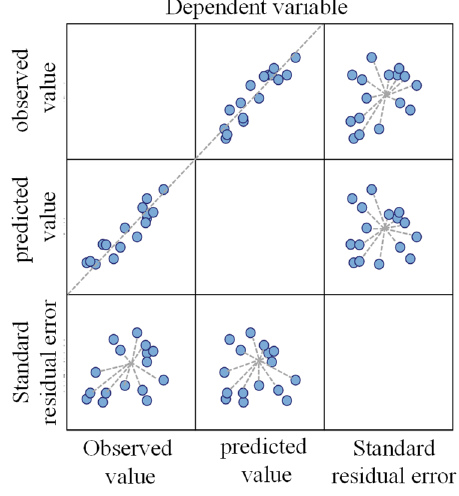
Figure 2. Residual scatter diagram of ANOVA.